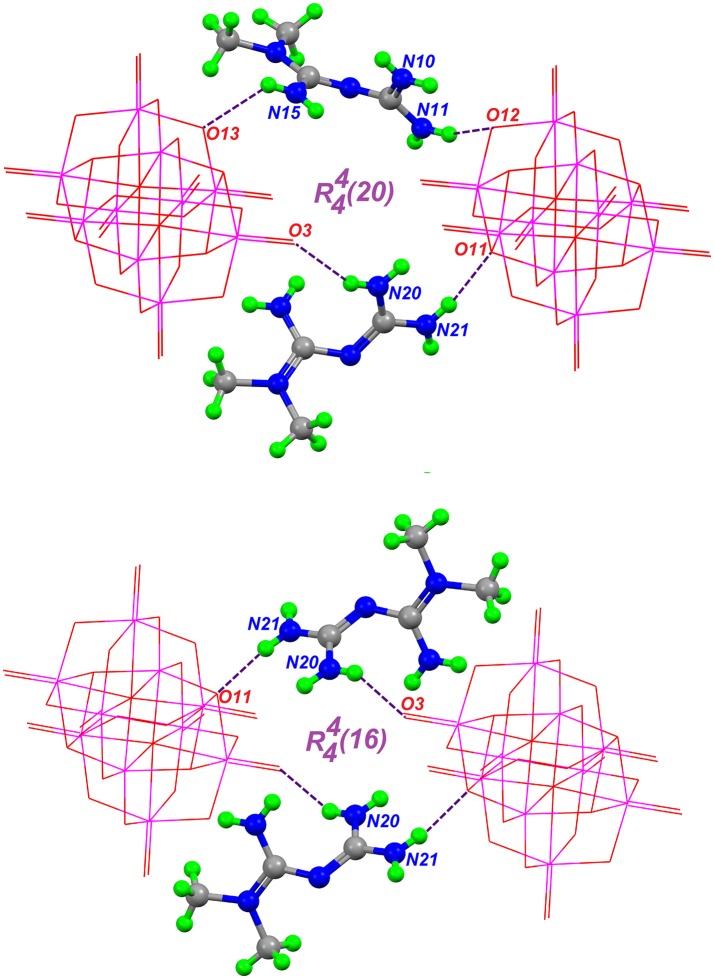
Hydrogen-bond patterns in Compound 2, formed through hydrogen bonds (purple dashed lines) between two HMetf cations and two symmetry-related [V10O28]6−moities.